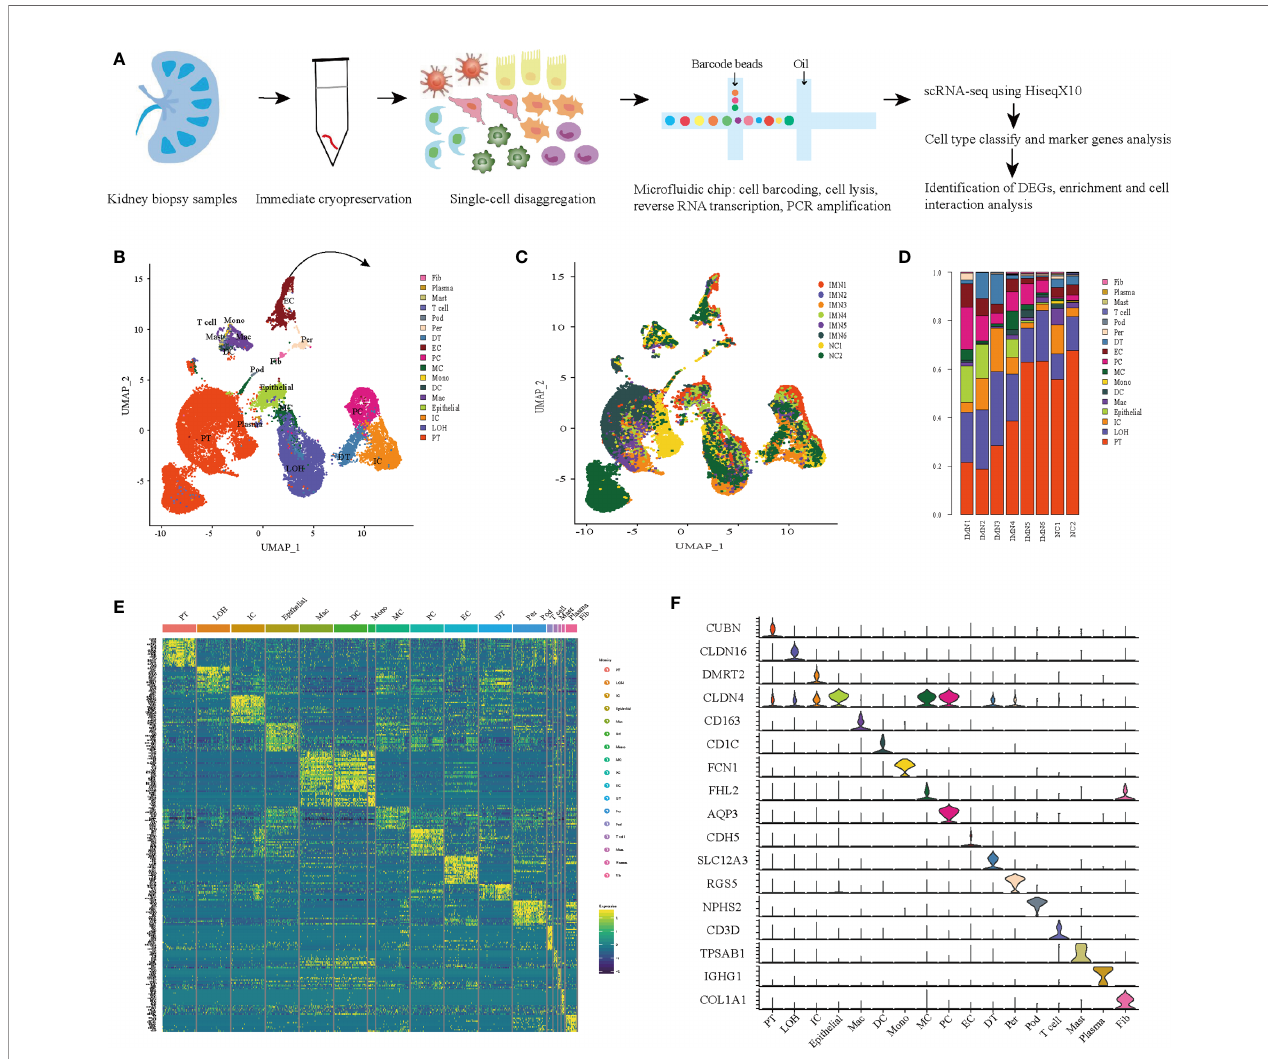
FIGURE 1 | Cell lineage analysis by comprehensive single-cell RNA-sequencing in anti-PLA2R positive IMN and control subjects. (A) Schematic of the scRNA-seq pipeline. Kidney samples from patients with IMN (n=6) or healthy control subjects (n=2) were collected at the time of clinically indicated renal biopsy or live kidney donation, respectively. Kidney biopsies were enzymatically disaggregated into single-cell suspensions and loaded onto a micro fl uidic device for cell barcoding, cell lysis, reverse RNA transcription, and then scRNA-seq as well as various other analyses. (B) Seventeen distinct cell clusters were visualized by UMAP plotting, with each cell color-coded for its associated subtypes. The color of the cells represents group origin. (C) UMAP plot of cell clusters from different subjects of IMN patients and control. The color of cells re fl ected the individual origin. (D) Bar plots of the percent contribution of cell clusters in kidneys from different subjects. Blocks represented different subjects, and block height was in proportion to the number of cells. (E) Heatmap of the top 20 most differentially expressed genes in each cluster to identify mutually exclusive gene sets, which were then used to determine the cell lineage of each cluster. Each column represented a cell cluster, and each row corresponded to a marker gene for the individual cluster. Transcript abundance ranges from low (purple) to high (yellow). (F) Violin plot of selected marker genes that identi fi ed the clusters generated by UMAP plotting. It was colored by different cell subtypes. PT, proximal tubule cells; LOH, loop of Henle cells; PC, principal cells; IC, intercalated cells; DT, distal tubule cells; EC, endothelial cells; Pod, podocytes; MC, mesangial cell; DC, dendritic cells; Mac, macrophages; Mono, monocytes; Fib, fi broblasts; Per,